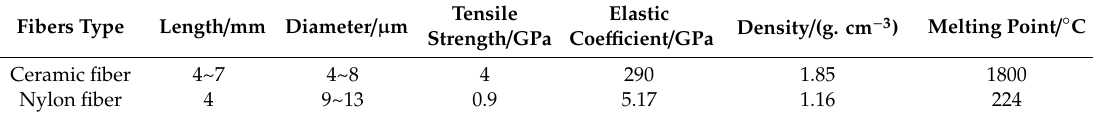
Figure 1. SEM image of nylon and ceramic fiber: ( a ) Ceramic fiber; ( b ) nylon fiber. Table 1. Main performance indicators of Table 1. Main performance indicators of fibers.